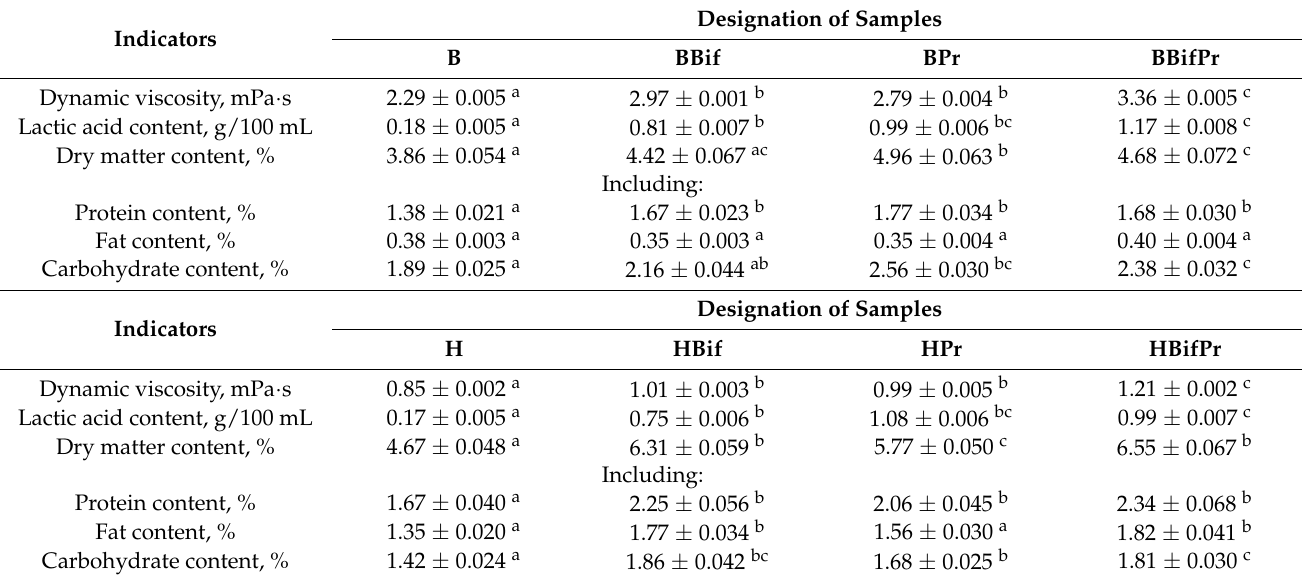
Table 2. The viscosity and biochemical composition of the grain-based